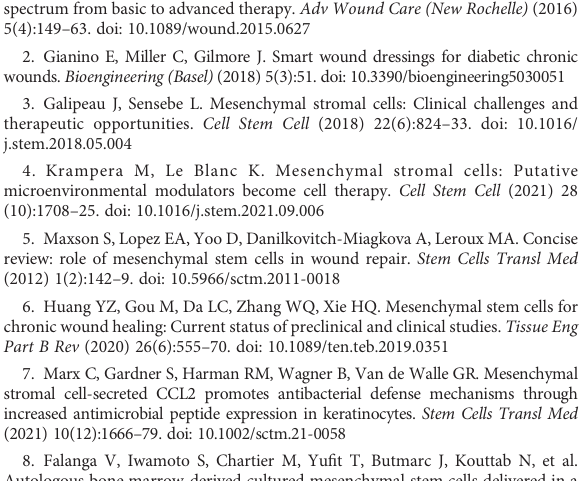
platelet-derived growth factor AB; VEGF, vascular endothelial growth factor; TNF- a , tumor necrosis factor alpha; IFN- g , interferon gamma;